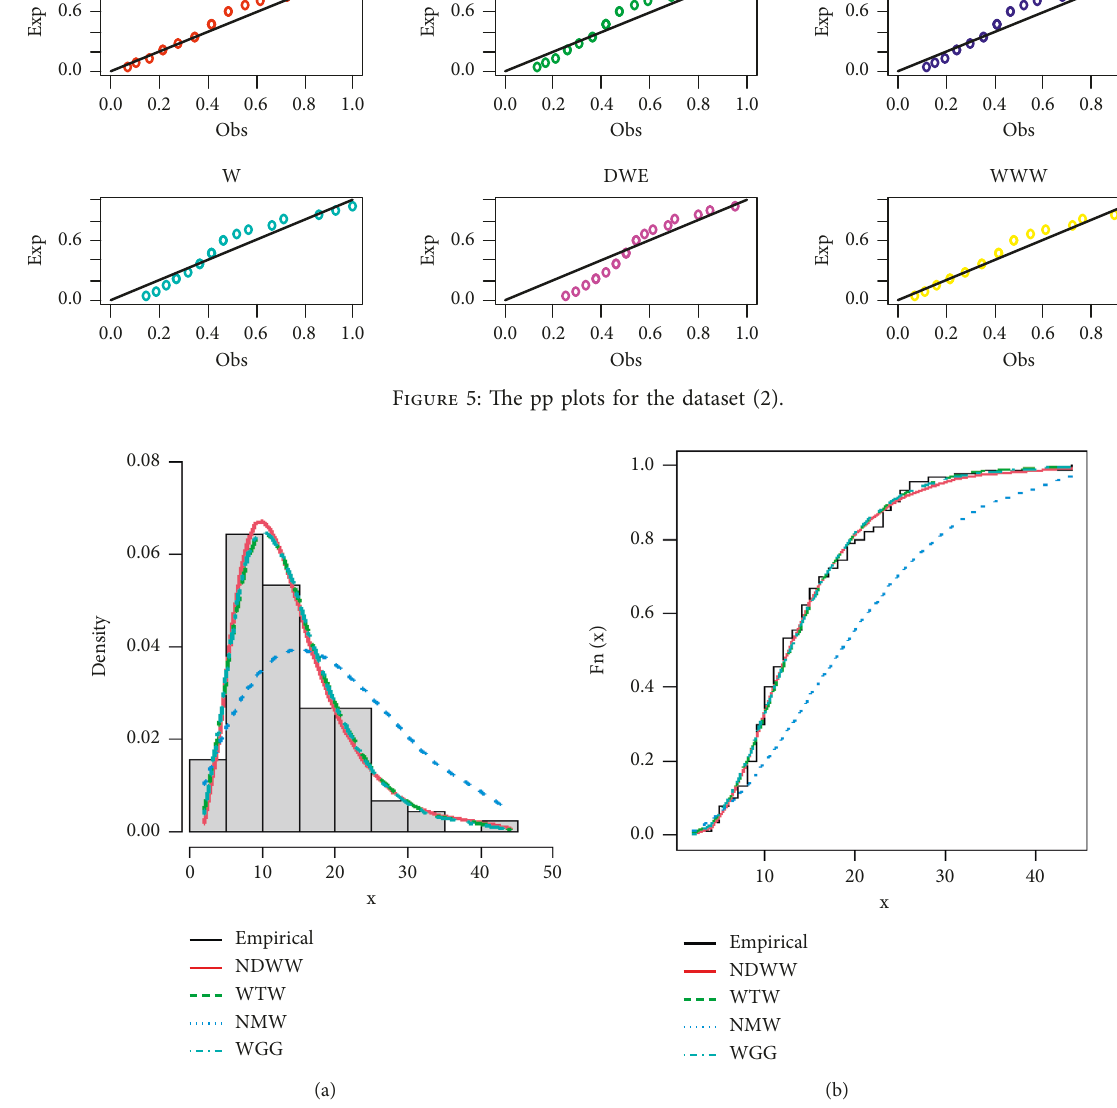
Figure 6: The fitted pdfs (a) and cdfs (b) for the dataset